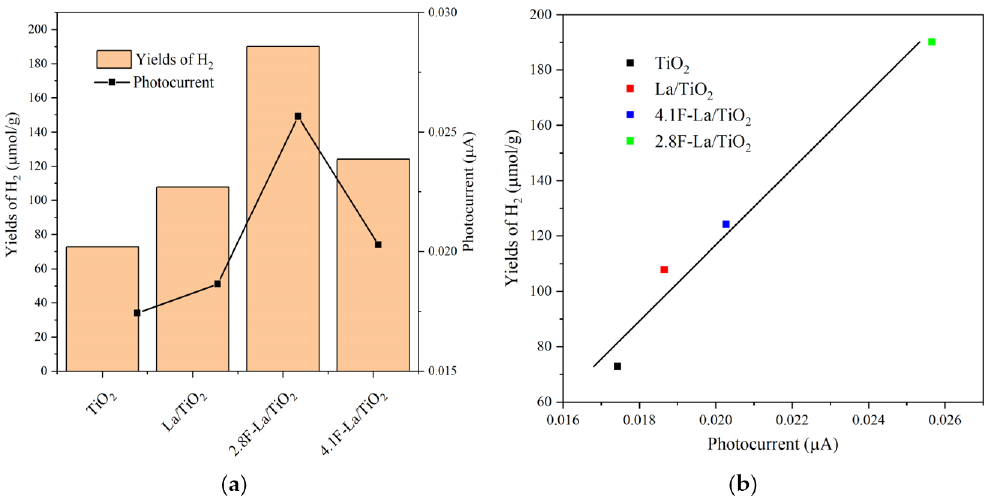
Figure 7. Correlation between the photocatalytic activity in the photocatalytic decomposition of methanol-water solution ( a ) and the hydrogen yields dependence on photocurrent ( b ) in the presence of the investigated photocatalysts and current generation. Current responses were obtained at 365 nm under external potential of 1.0